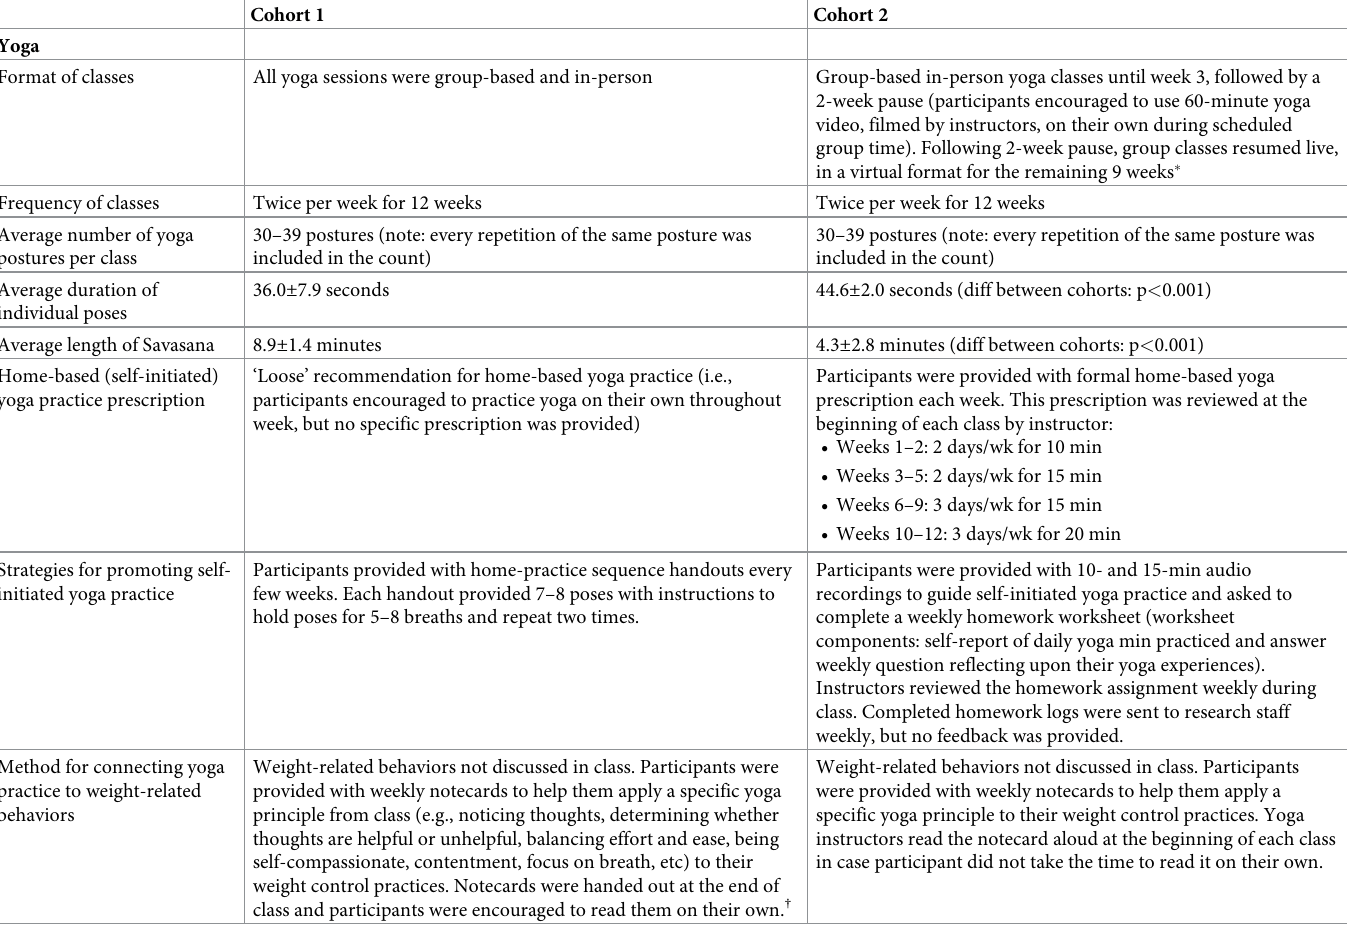
Table 1. Comparison of yoga Intervention by